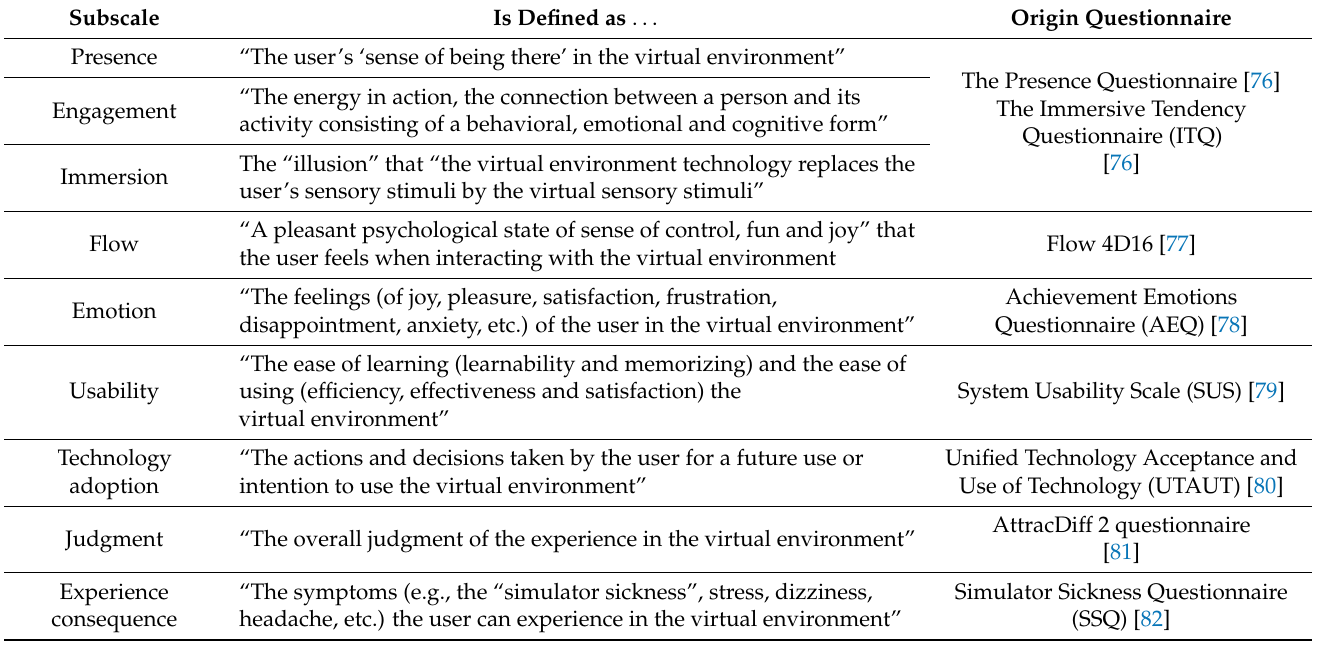
Table 1. Items of the Questionnaire on User eXperience in Immersive Virtual Environments consid- ered in the present research. Is Defined as . .